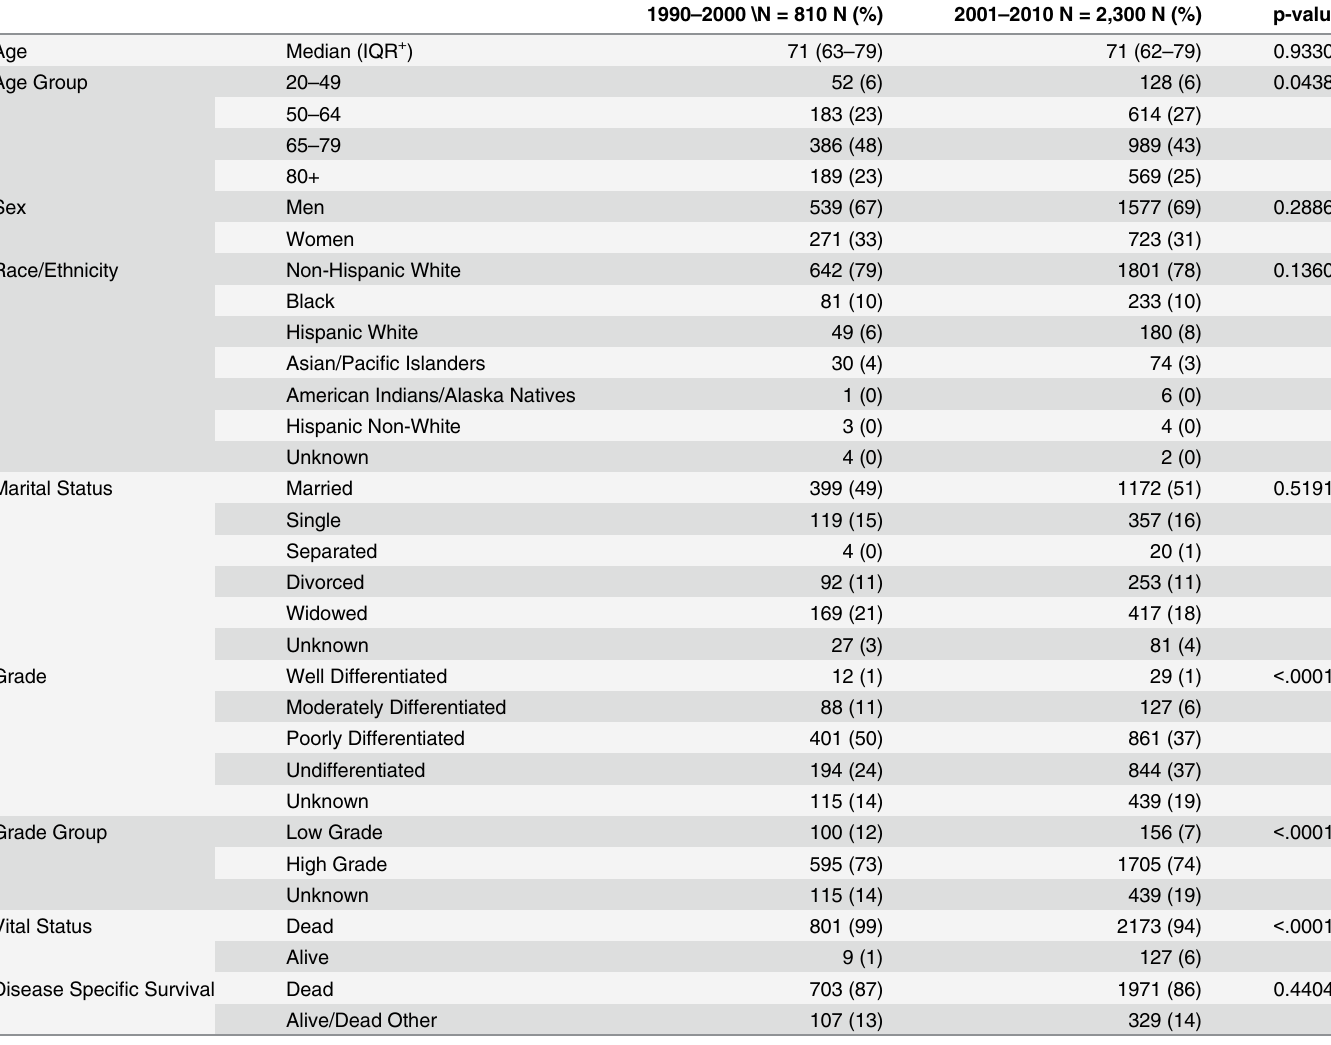
Table 2. Patient, tumor and treatment-related characteristics in patients stratified by time